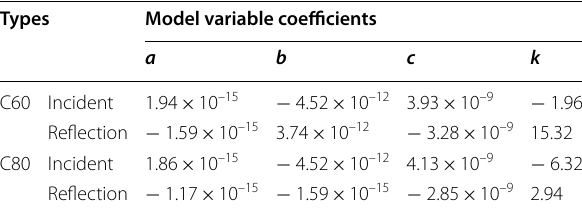
Table 5 Calculated coefficients of C60 and C80 one- dimensional nonlinear